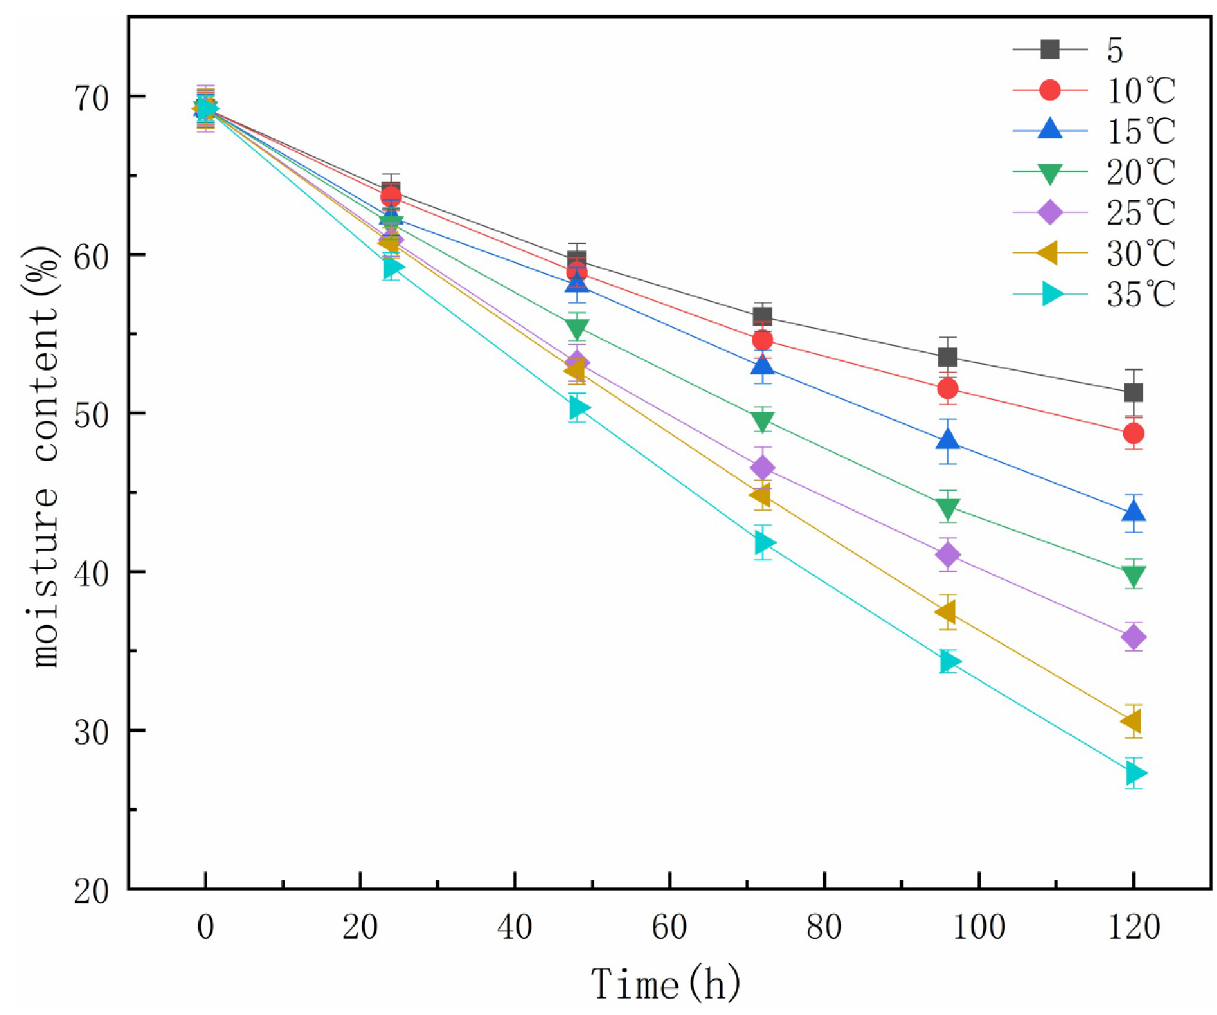
Fig 3. Effect of temperature on the moisture content of oily